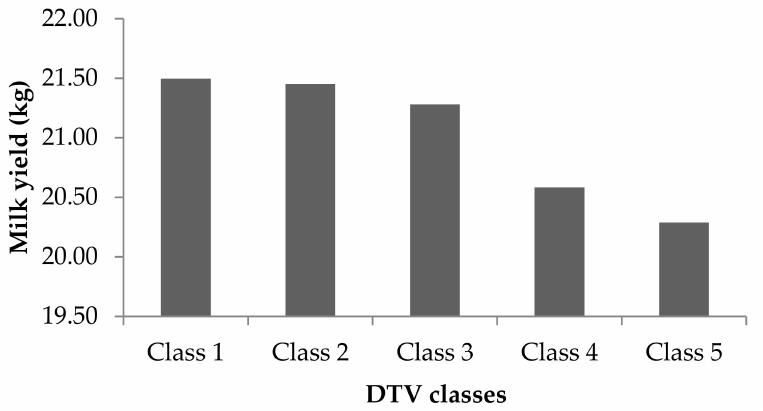
Figure 5. Solution of fixed effect (BLUE) of temperature variation (DTV) according to classes consid- ered in the model 4 (M4) model using Legendre polynomials.